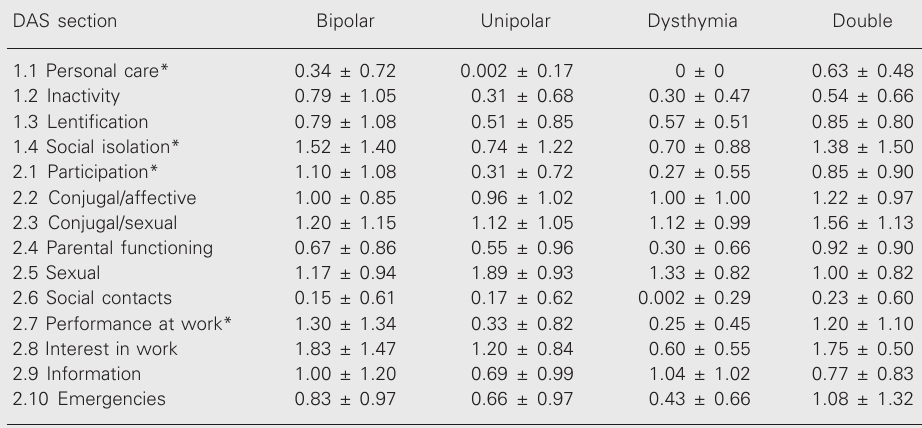
Data are reported as means ± SD.